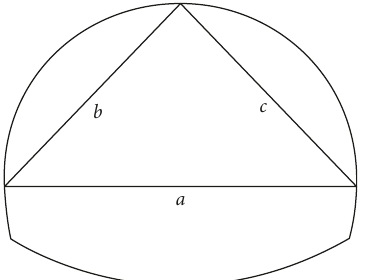
Figure 10: Layout of the measuring points of the cross